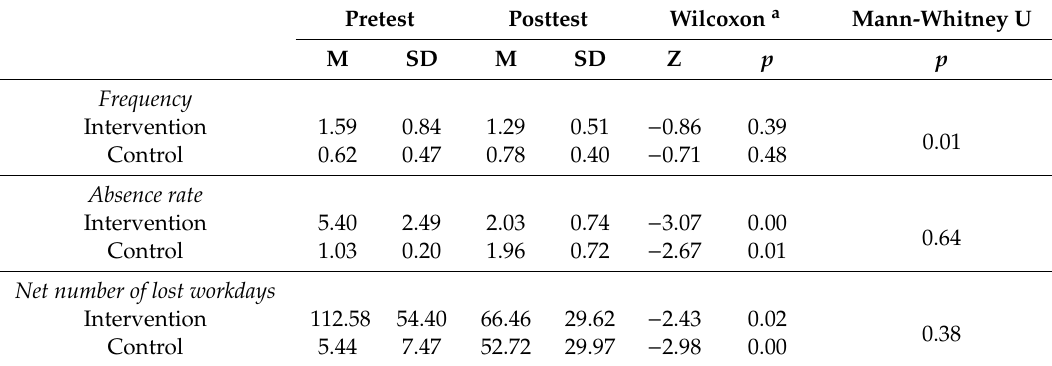
Table 4. Absenteeism in the intervention and control group. Pretest